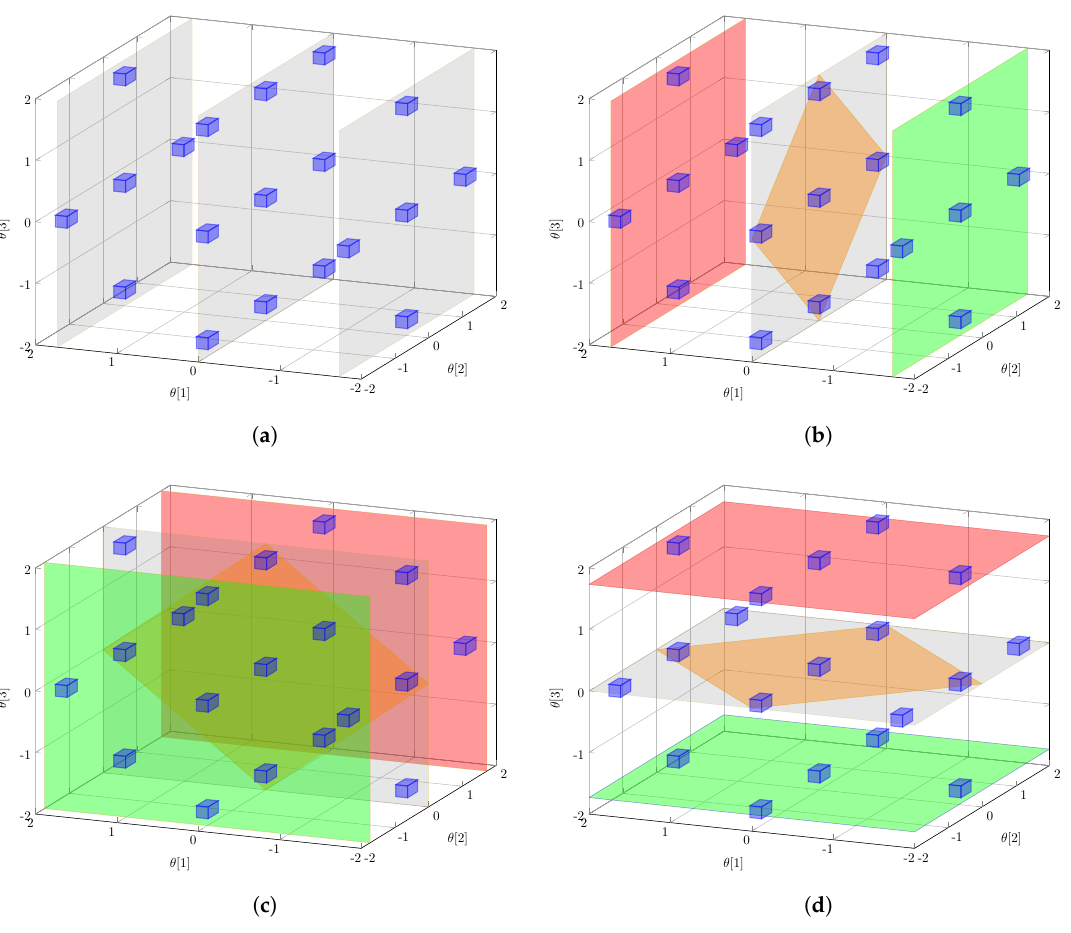
Figure 2. Parameter subset selection: Starting from an unconditioned parameter sample set ( a ), subsets are systematically selected in ( b – d ) to determine conditioned expectations and variances,